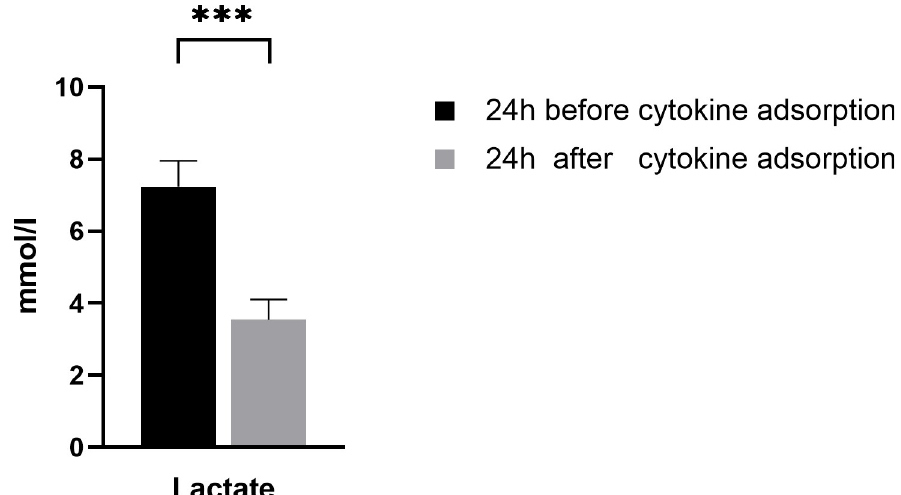
Fig 4. Serum lactate levels before and after cytokine adsorption. Graphs show mean serum lactate level before and after cytokine adsorption. Data shows n = 76 patients. Error bars correspond to SEM. Asterisks mark differences between both groups at a significance ��� p < 0.001.